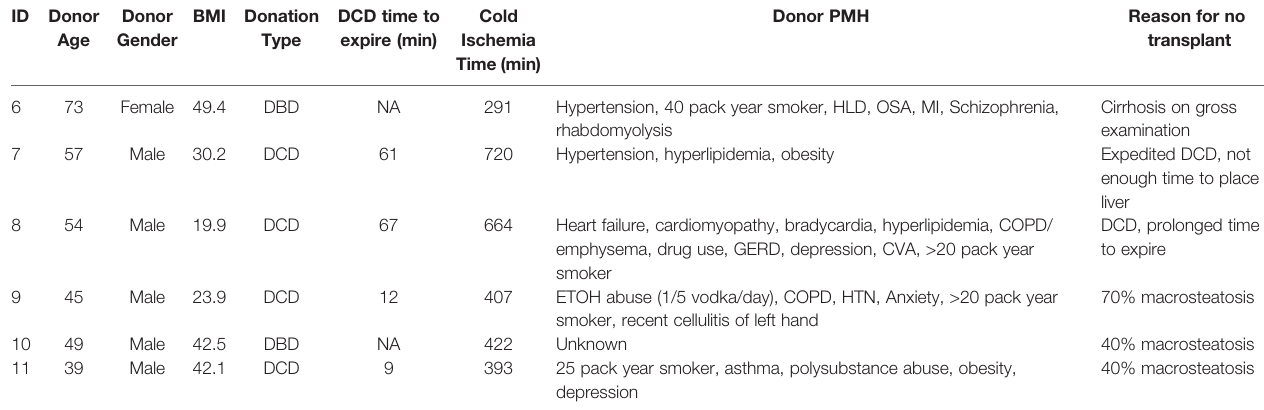
TABLE 1 | Liver donor medical history and